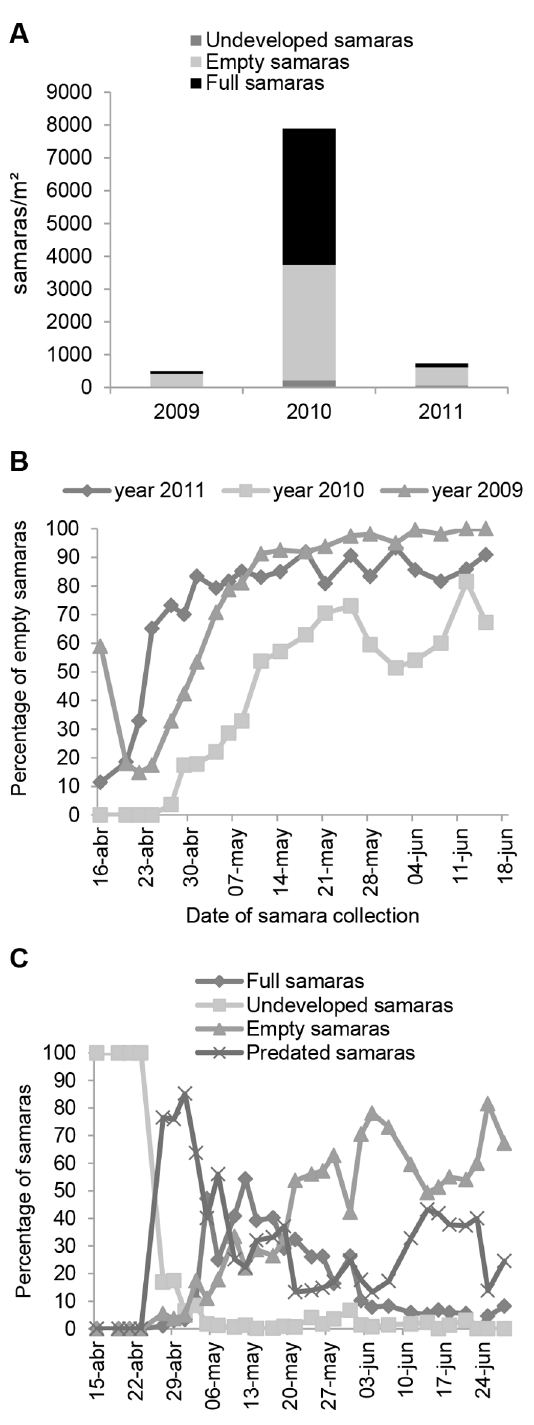
Figure 2. Samara production. a) Fruit crop size for each samara category and season; b) proportion of empty samaras dispersed throughout each season; c) proportion of each samara category dispersed along the mast year